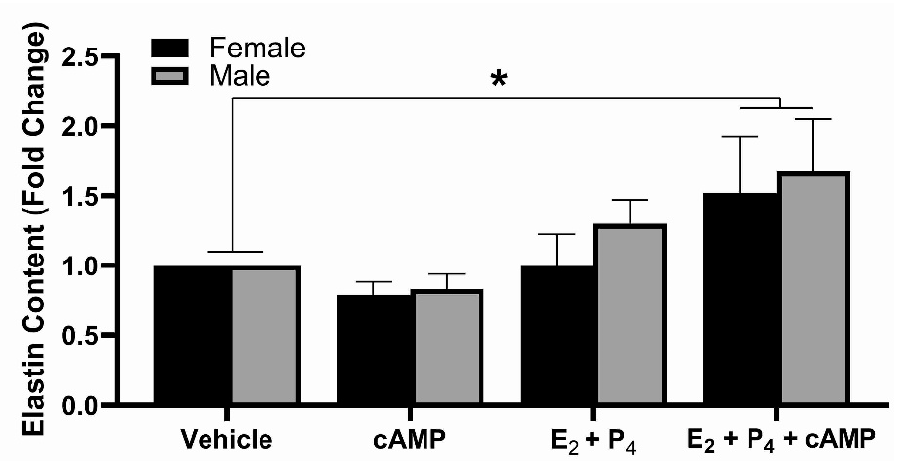
Figure 4. Effects of cAMP on elastin synthesis. The addition of cAMP alone does not affect elastin synthesis; however, when added with E 2 and P 4 an increase in elastin synthesis in both male and female EDS occurs. n = 5; * indicates p < 0.05.